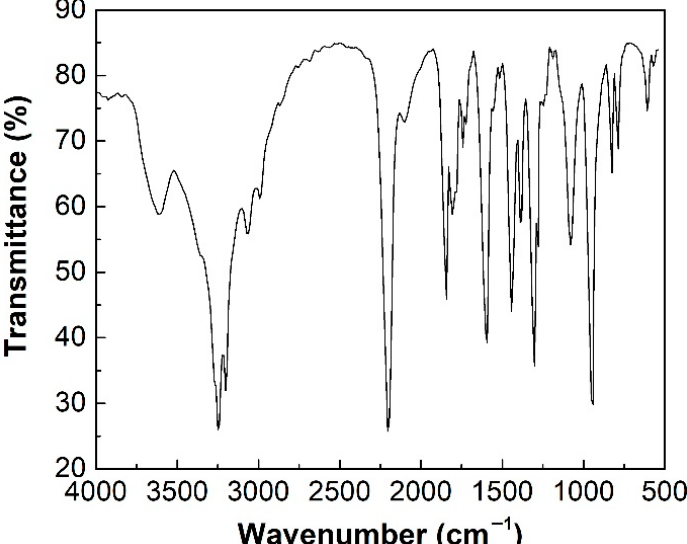
Figure 1. The FTIR spectrum of chain transfer agent, DMPA.